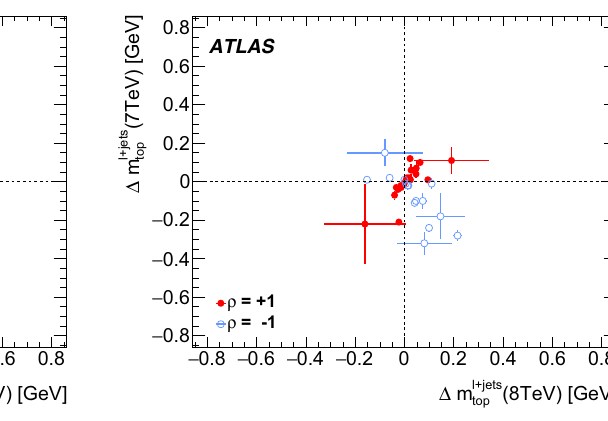
(c) t ¯ t → lepton + jets (8 TeV) and t ¯ t → alljets (8 TeV) Fig. 7 The pairwise shifts in m top when simultaneously varying a pair of measurements for a systematic uncertainty or a subcomponent of a systematic uncertainty. a , b show the correlations of the t ¯ t → dilepton √ s = 8 TeV with the two other measurements at the measurement at same centre-of-mass energy for all sources of uncertainty for which the estimators are correlated. c shows the correlations of the present